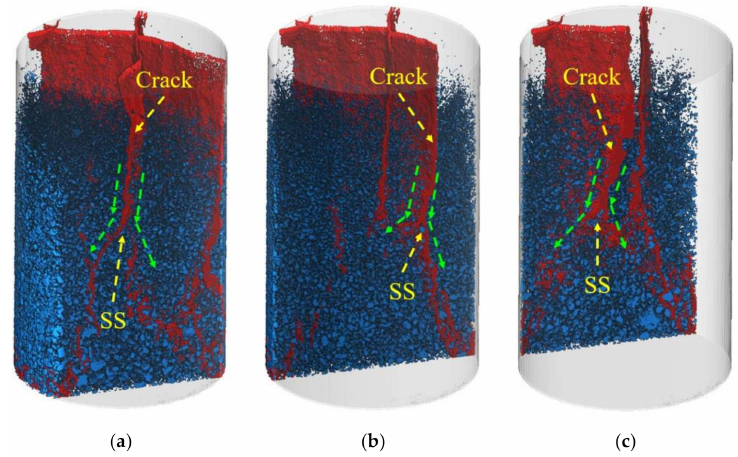
Figure 9. Effect of SS particle cracks propagation direction (Gypsum: 10 wt. %, FA: 40 wt. % and SS: